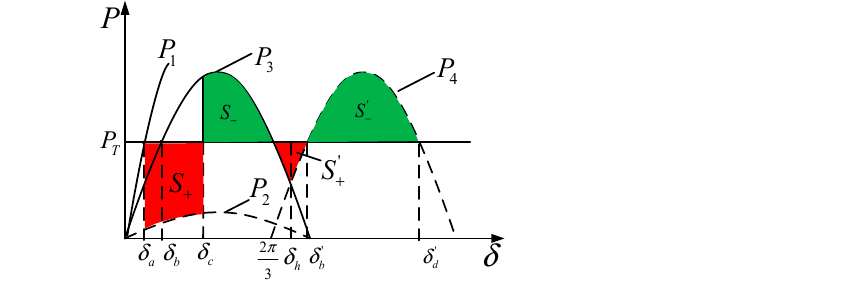
Figure 4. Power angle characteristic curve before and after phase sequence exchanging.